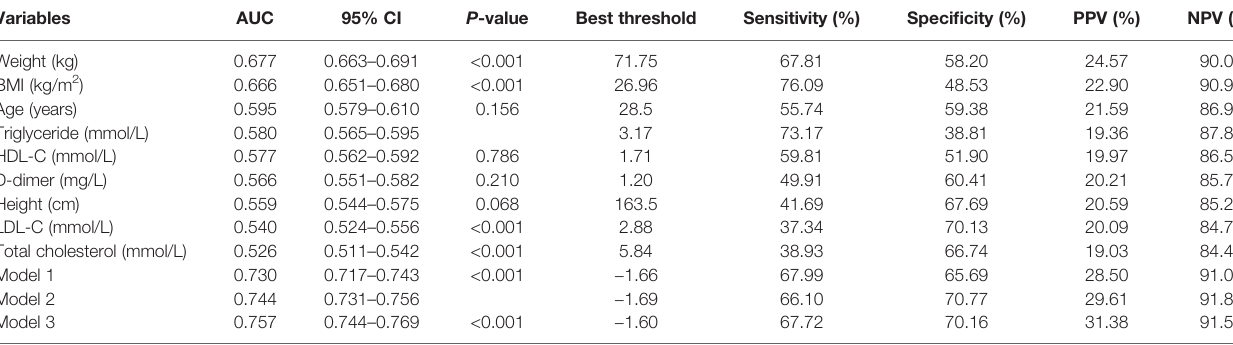
TABLE 6 | Accuracy of different models and variables in late pregnancy to predict LGA.